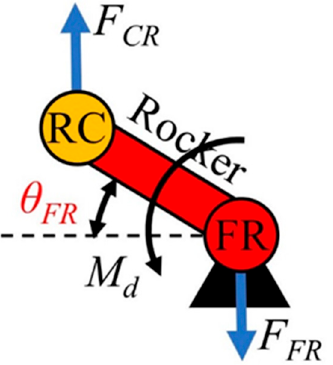
Figure 8. Force analysis of the rocker.